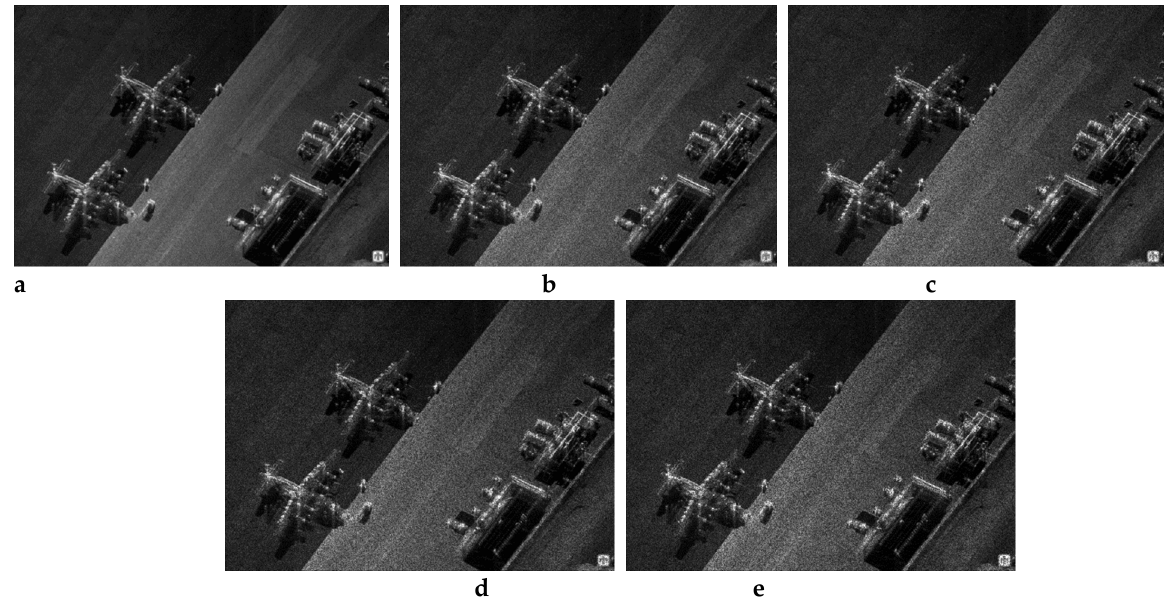
Figure 13. ( a ) SAR image, ( b ) noisy image (noise variance = 0.04), ( c ) noisy image (noise variance = 0.06), ( d ) Noisy